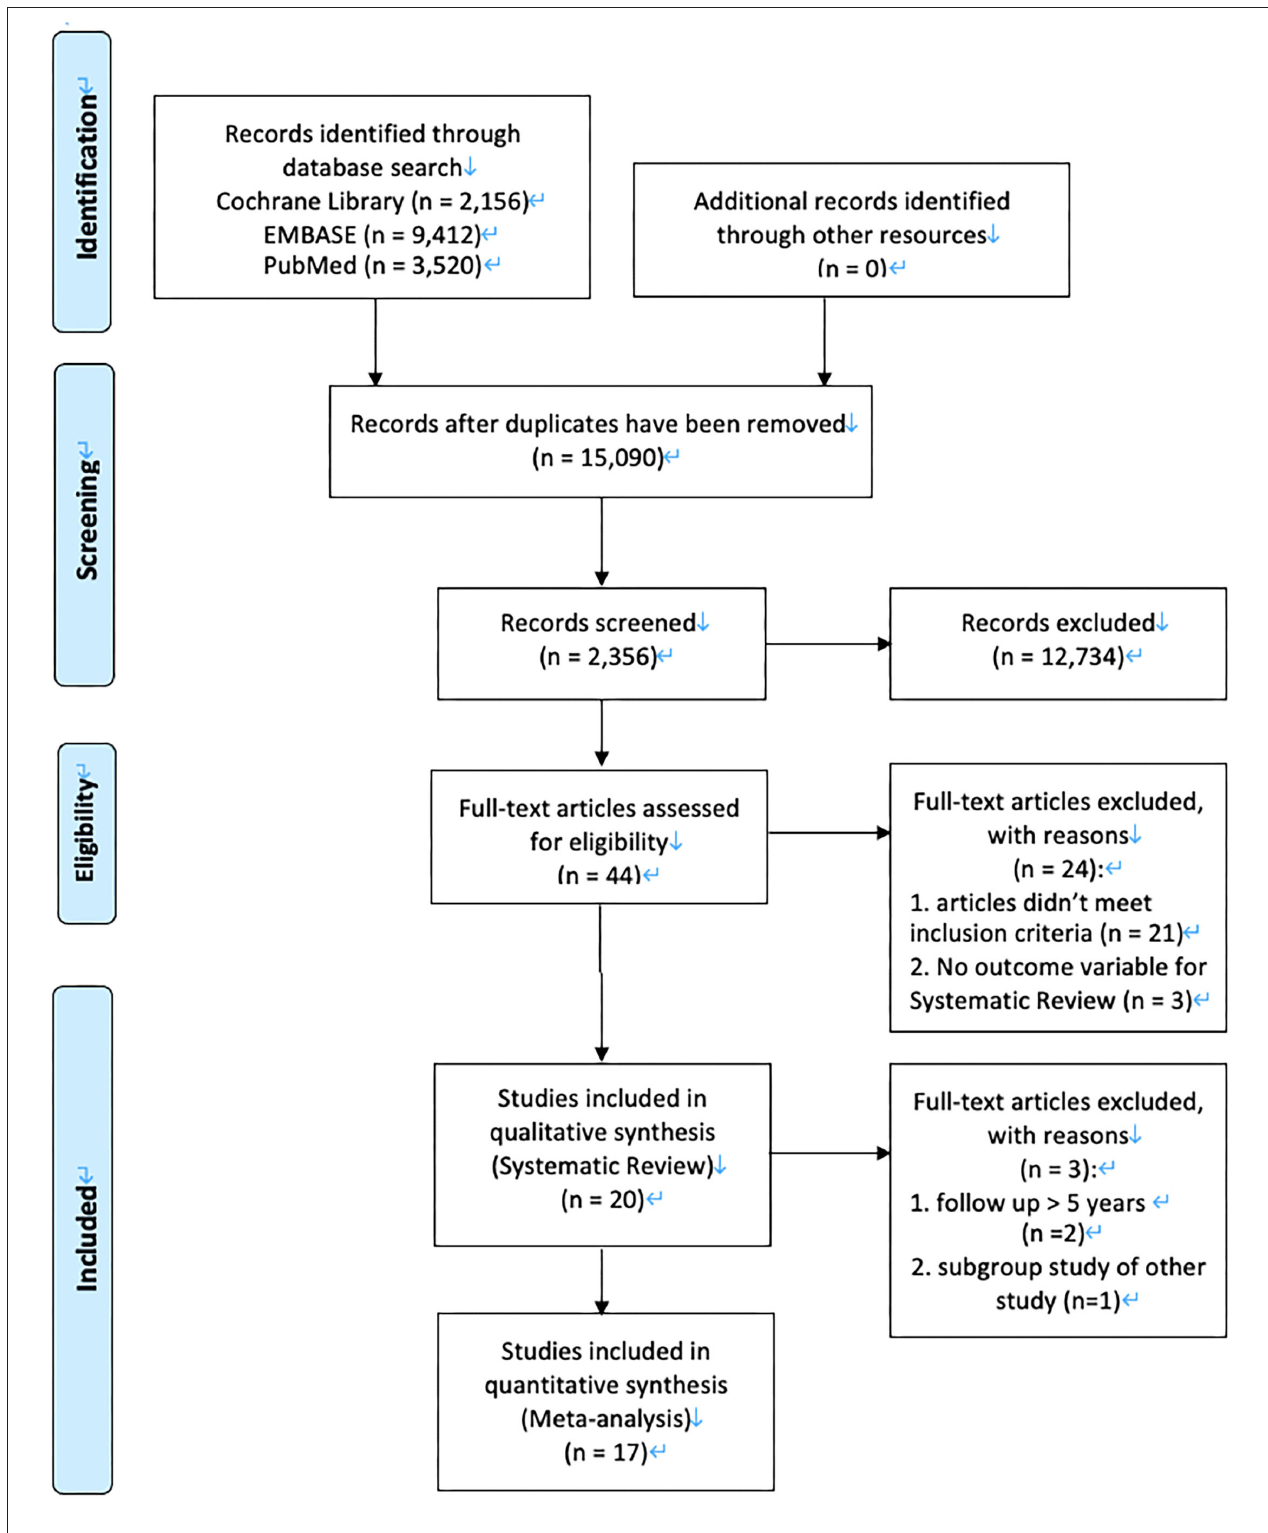
FIGURE 1 | PRISMA flow